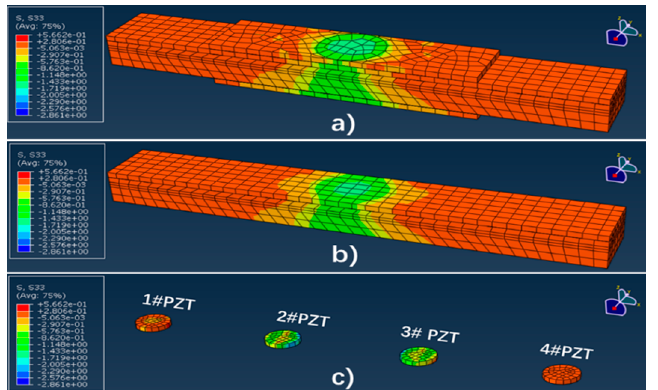
Figure 17. The stress distribution of the system when the equivalent load amplitude is 10 kN. ( a ) Load stress distribution; ( b ) system stress distribution; ( c ) piezoelectric single stress distribution.